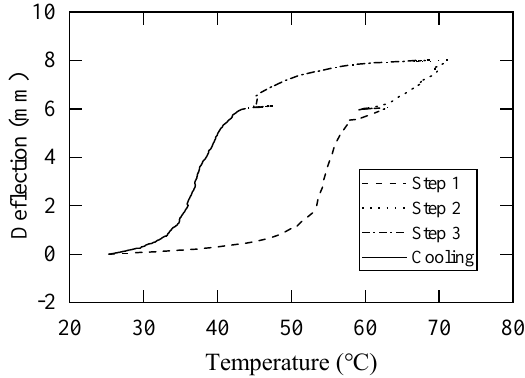
Figure 19. Temperature – deflection result. For model-free control, deflection is used as the feedback quantity of the control system, and temperature feedback related to the Preisach model of the SMA-based actuator is removed. With the other conditions being unchanged, the effect of the modeled control and the model-free control is compared in Figure 20. In Step 1, both the model control and model-free control present a better control effect. Compared to the model control, the model-free control shows a slightly longer steady-state time. In Step 2, compared to the modeled control, in addition to the long steady-state time, the model-free control shows a large amount of overshoot. In Step 3, the model-free control cannot reach the control target within 300 s. On the contrary, the model control presents a good control effect. As a result, the time-domain performance index of the modeled control and model-free control includes steady-state time, steady-state error, and relative error, which are summarized in